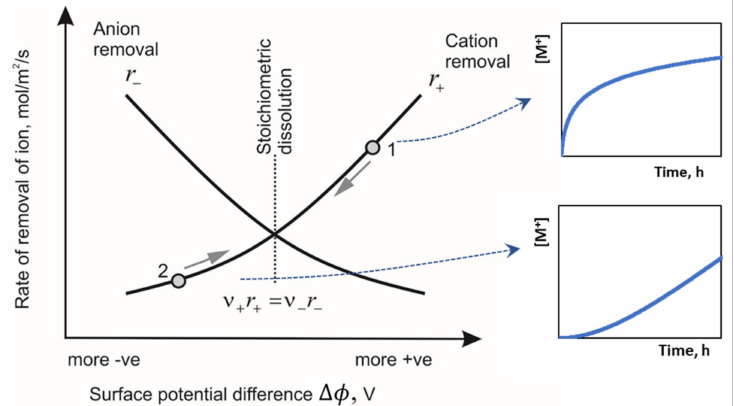
Figure 16. The explanation for falling or accelerating initial rates. If the surface charge upon the start of the test is higher than the condition for stoichiometric dissolution, shown as point 1, the removal of cations will drop as the potential moves towards the stoichiometric point. If, on the other hand, the initial charge is lower than the stoichiometric condition, as shown as point 2, the rate will appear to